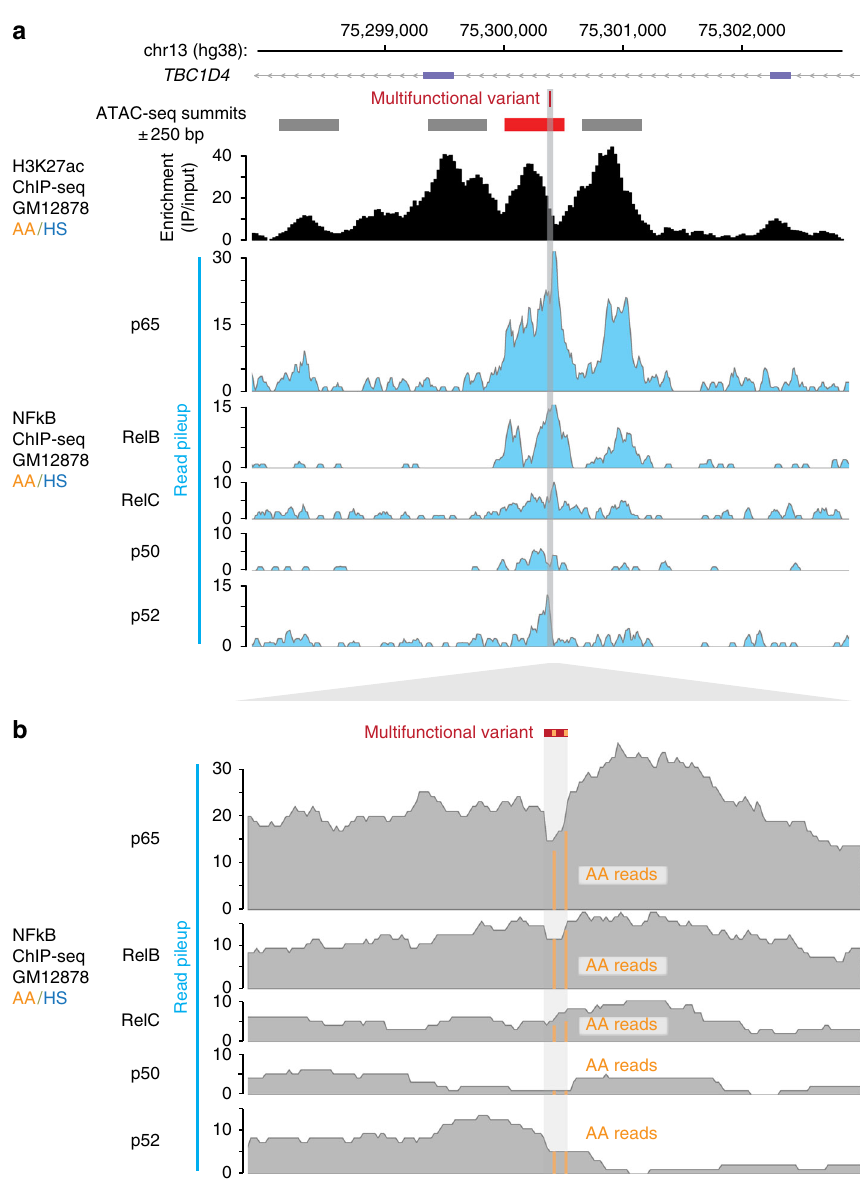
Fig. 7 Allele-speci fi c binding of NFkB at variant locus ChIP-seq read pileups for NF κ B components p65, RelB, RelC, p50, and p52 from the heterozygous AA/HS GM12878 cell line, showing the 5 kb context above ( a ), and a ~200 bp detail (below; b ) showing most reads of each NF κ B component are from the